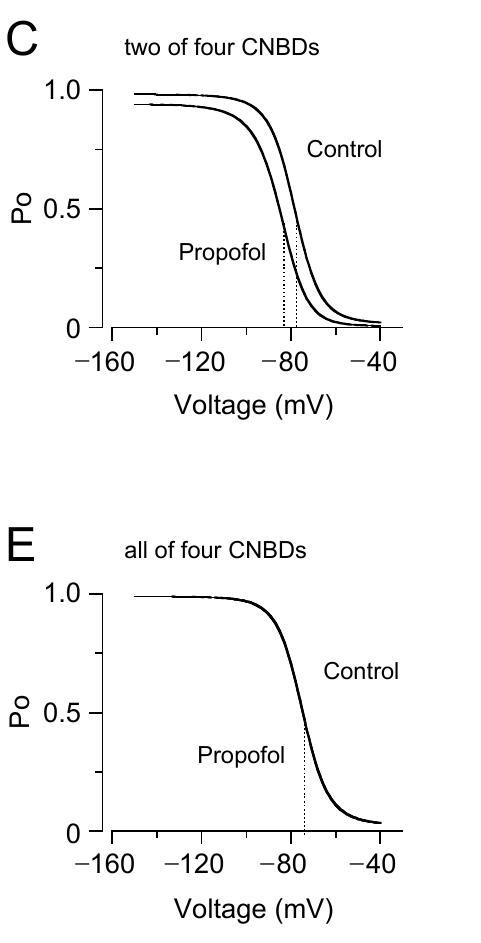
Figure 5. Simulation of the attenuated effects of propofol by activation of the CNBDs. The P O - V curves in the presence and absence (control) of propofol were simulated depending on the activation state of CNBDs: none ( A ) and one to all ( B – E ) of four CNBDs activated. The vertical dashed line indicates the V h